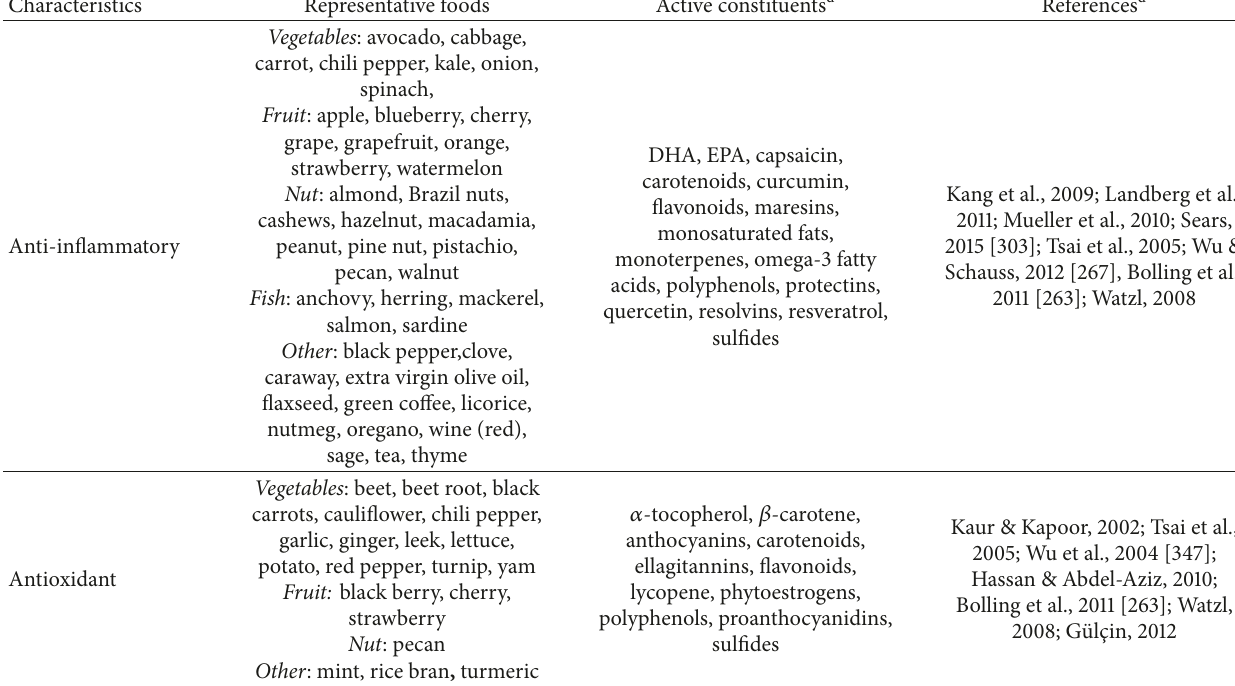
Table 7: Foods which have moderate-to-strong anti-inflammatory a , c and antioxidant b , c effects.